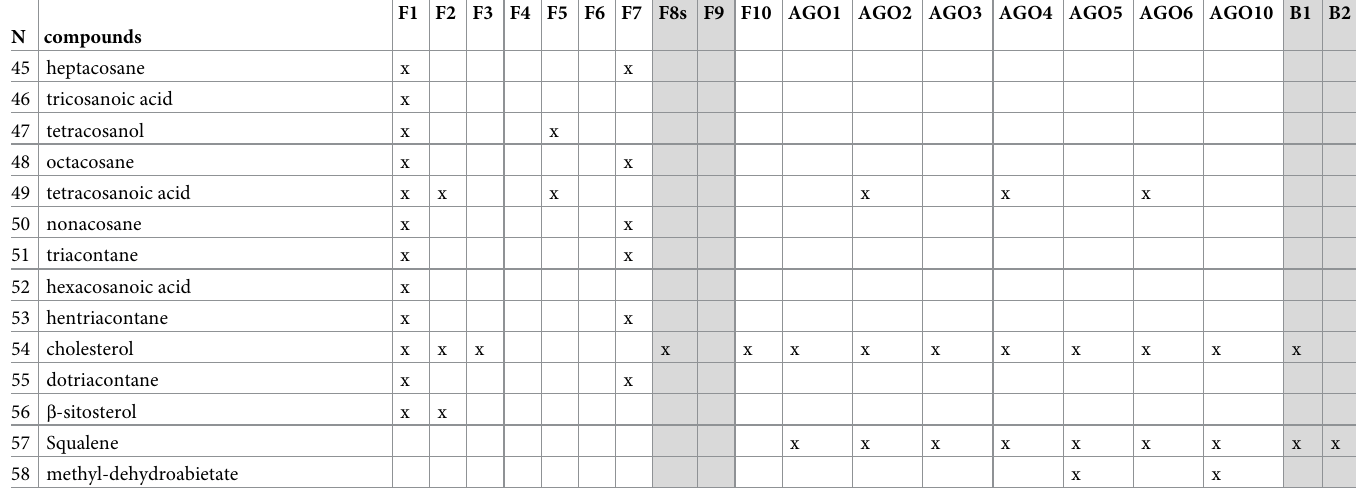
PLOS ONE | https://doi.org/10.1371/journal.pone.0213473 June 20,